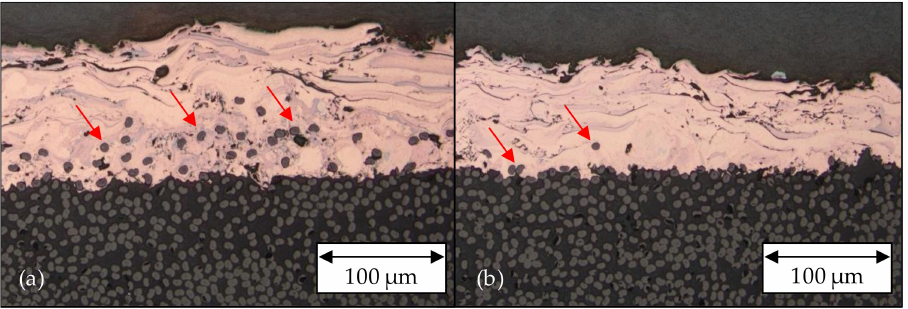
Figure 9. Cross-sections of wire arc copper coated laser-structured (( a ) CO2_SMR, ( b ) USP_SMR) CFRP with enclosed fibers indicated by red